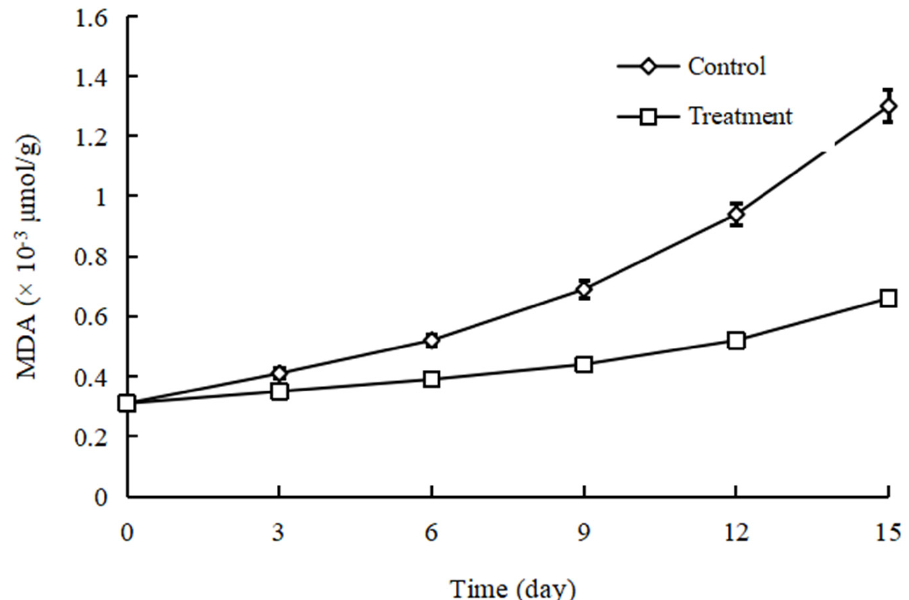
Figure 6. Effect of pullulan-based coatings on the MDA content of cowpeas during refrigerated storage. Bars represent the standard deviation ( n = 6).